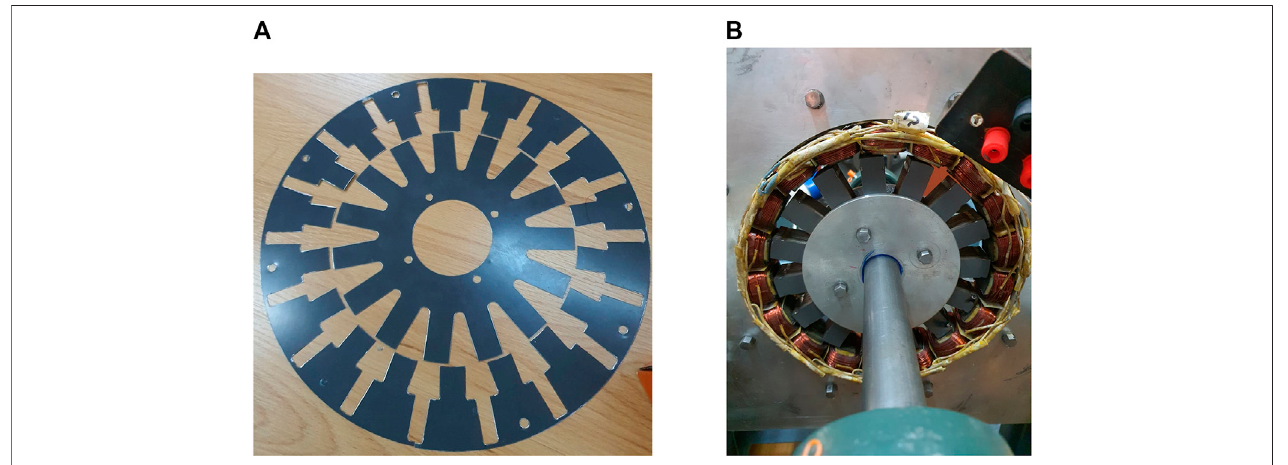
FIGURE 9 | The 18/15-poles DSPM prototype machine (A) laminated stator and rotor, and (B) assembled prototype machine.